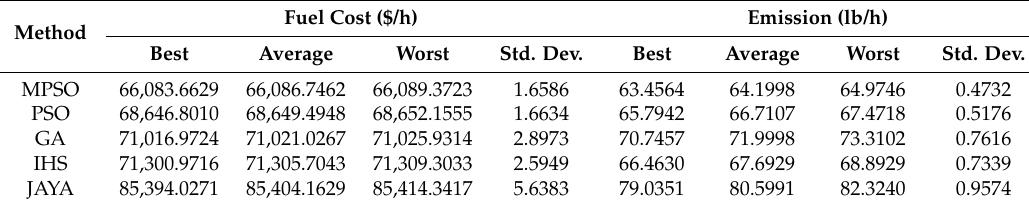
Table 4. Statistical analysis of the heuristic algorithms in terms of total fuel cost and emission.